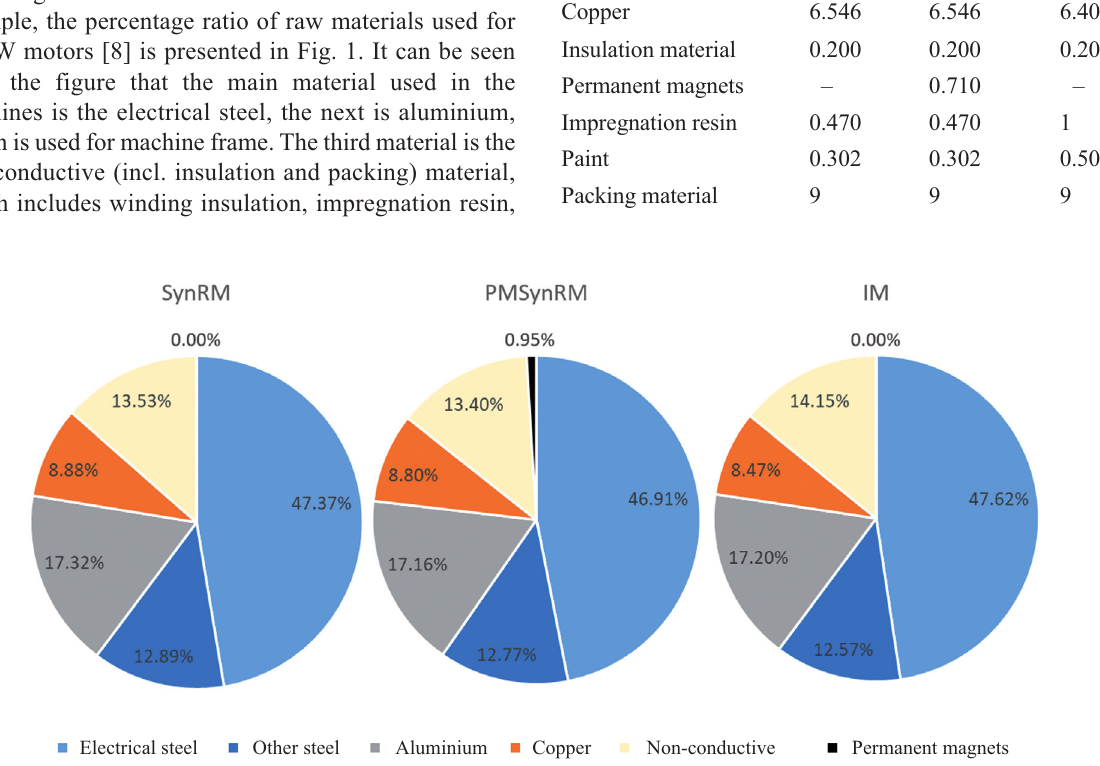
Fig. 1. Percentage ratio of raw materials used for different 10 kW motors production.